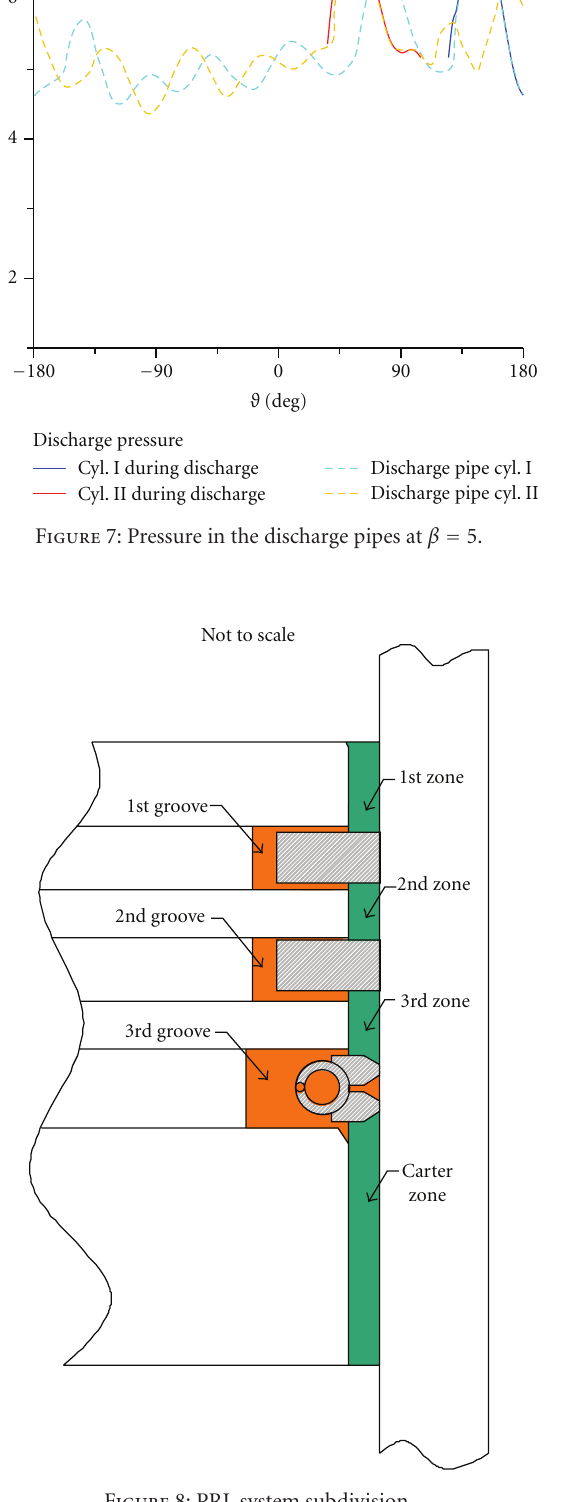
Figure 8: PRL system subdivision.